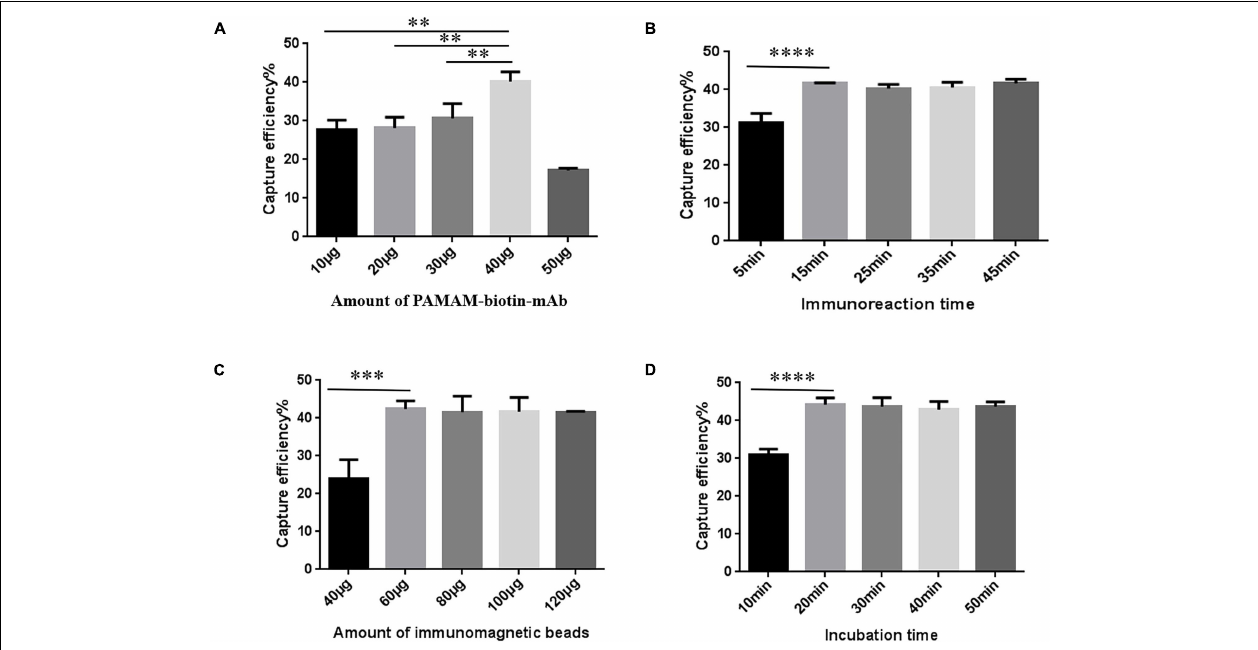
FIGURE 4 | Optimization of Polyamidoamine (PAMAM) dendrimer/SA-biotin mediated cascade-amplification IME (P-SA-BA-IME) conditions. (A) Amount of biotin-PAMAM- monoclonal antibody (mAb) optimization. (B) Optimization of immunoreaction time of biotin-PAMAM-mAb with noroviruses. (C) Optimization of the amount of immunomagnetic beads. (D) Optimization of incubation time. Optimization of the conditions of P-SA-BA-IME, the best condition according to the capture efficiency under different conditions is selected based on the principle of high capture efficiency, and time and cost saving. ∗∗ P < 0.01, ∗∗∗ P < 0.001, ∗∗∗∗ P < 0.0001.